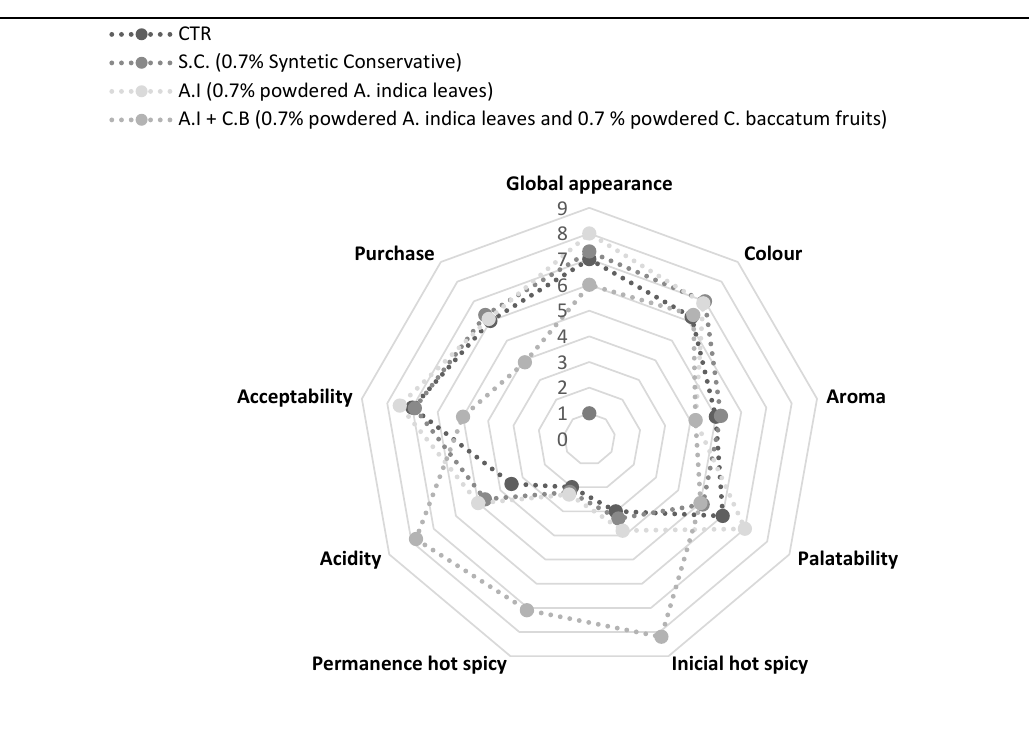
Figure 6. Sensorial analysis of CTR (Control sample without antioxidant), S.C (treatment with 0.7% (w/w) synthetic conservative), A.I (treatment with 0.7% (w/w) powdered A. indica leaves), and A.I + C.B (treatment with 0.7% (w/w) powdered A. indica leaves and 0.7% (w/w) powdered C. baccatum fruits).